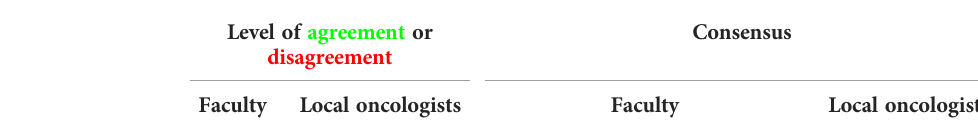
TABLE 2 Level of agreement and disagreement and consensus status on statements regarding early